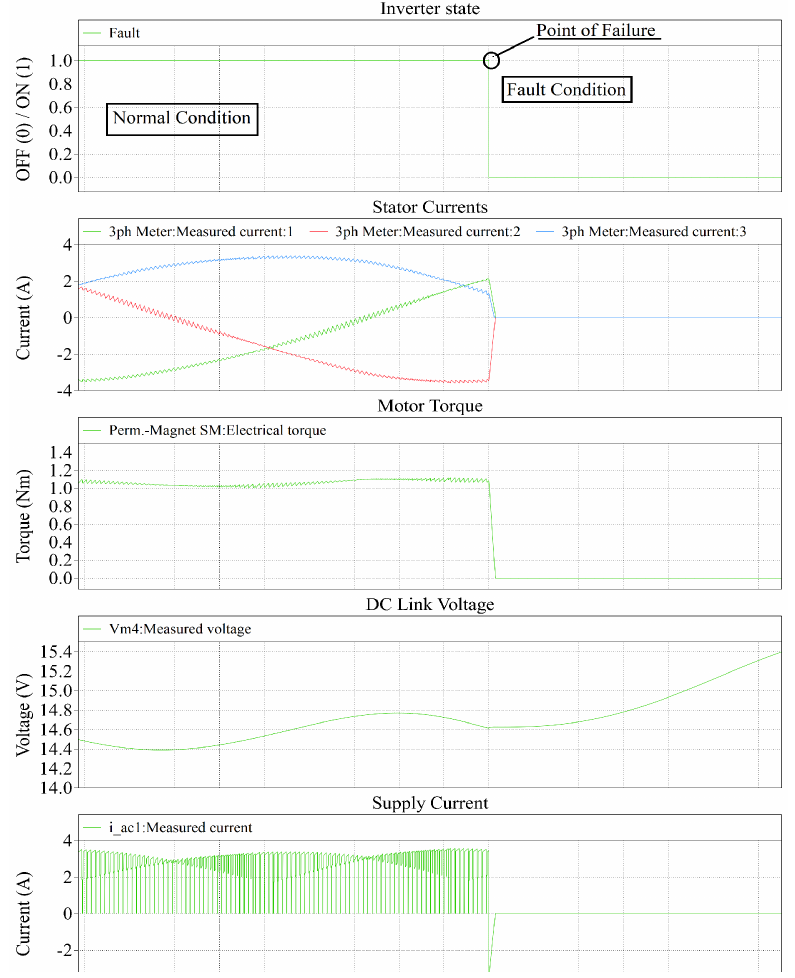
Figure 18. Transient simulation of inverter failure fault, showing the inverter state, stator currents i abc , motor torque T e , DC link voltage V o , and supply current i o